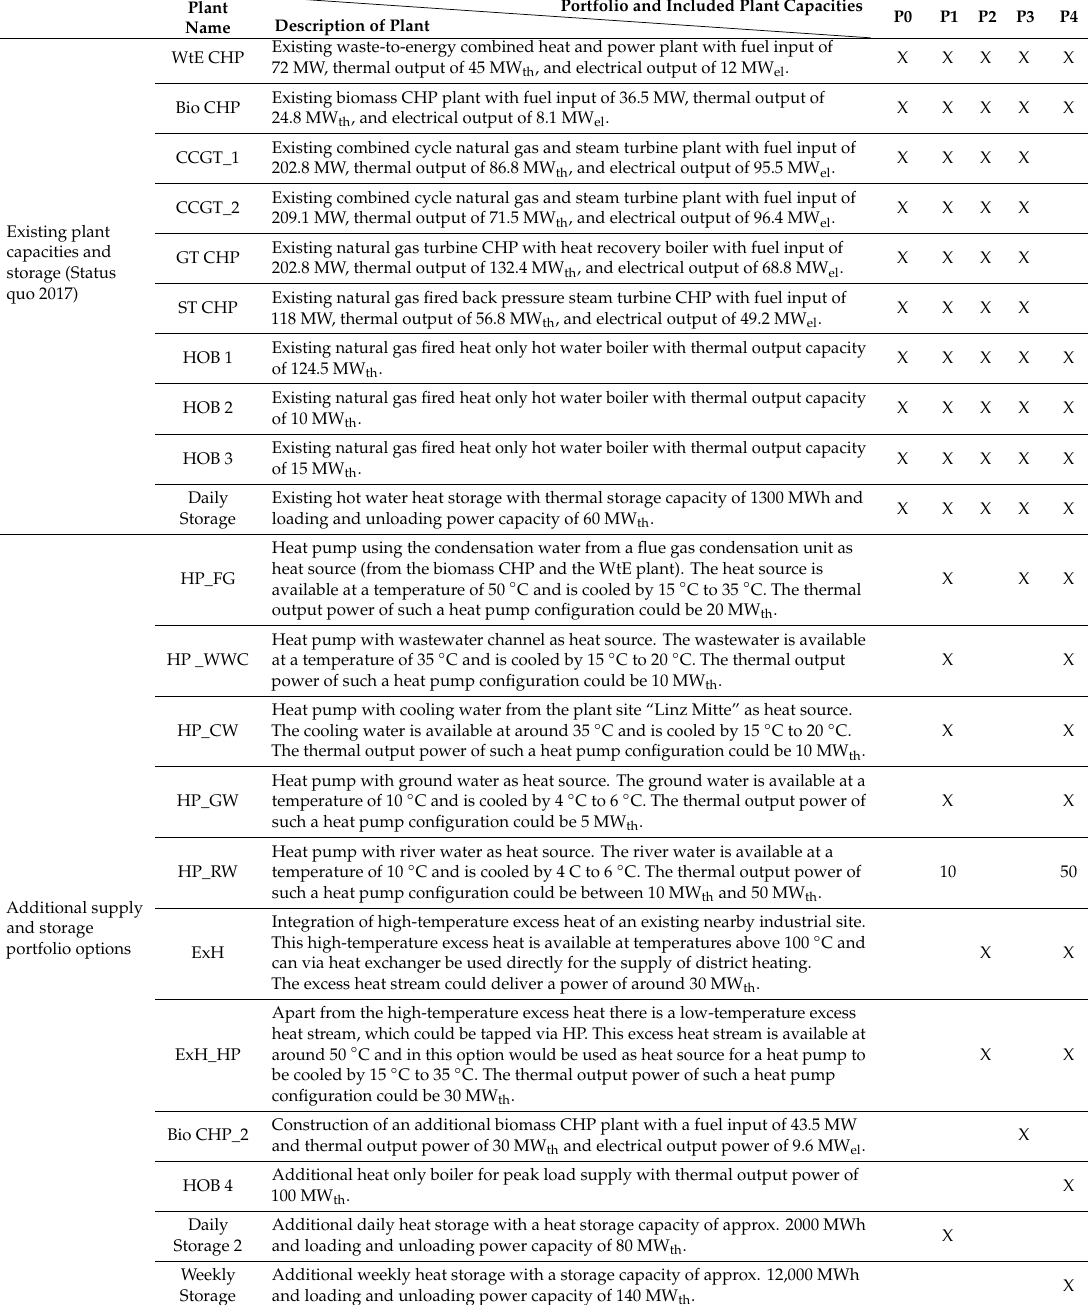
Table 2. Description of status quo plant capacities and future portfolio